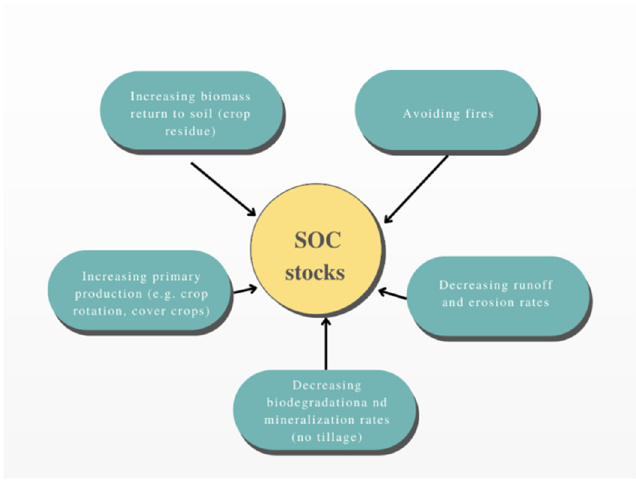
Figure 5. CA practices that increase SOC